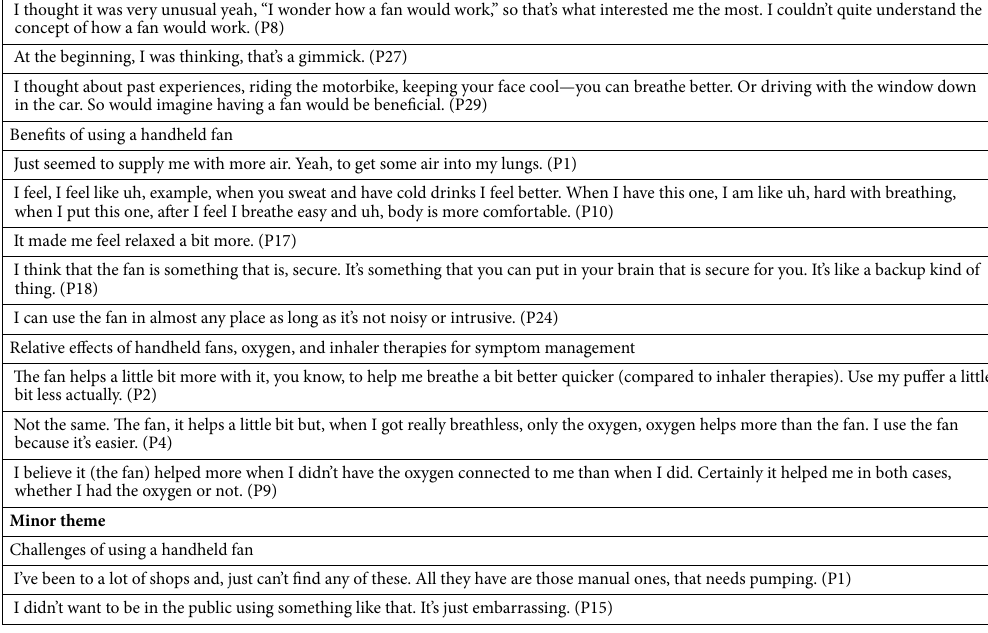
Table 3. Major and minor interview themes with illustrative